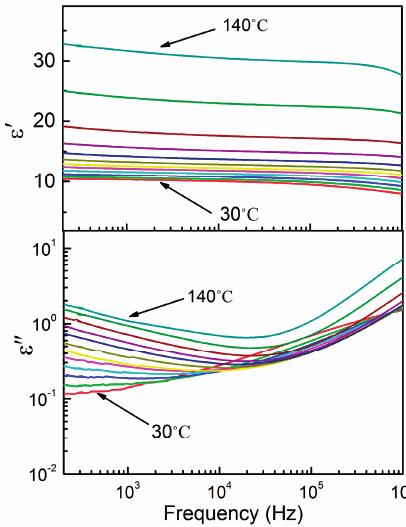
Figure 7. Dielectric frequency spectra for the P(VDF-TrFE) thin film annealed at 100 °C and measured at a temperature step size of 10 °C from 30 °C to 140 °C.